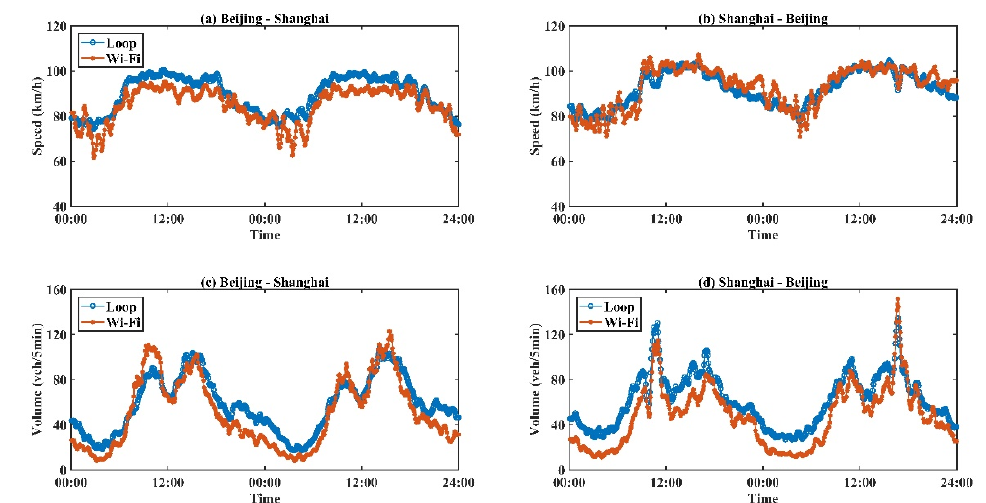
Figure 5. Comparisons between speed and volume obtained from Wi-Fi signal-based system and loop detectors. ( a ) Comparison results between speed obtained from loop detectors and Wi-Fi signals for Beijing to Shanghai over time, ( b ) Comparison results between speed obtained from loop detectors and Wi-Fi signals for Shanghai to Beijing over time, ( c ) Comparison results between volumes obtained from loop detectors and Wi-Fi signals for Beijing to Shanghai over time, ( d ) Comparison results between volumes obtained from loop detectors and Wi-Fi signals for Shanghai to Beijing over